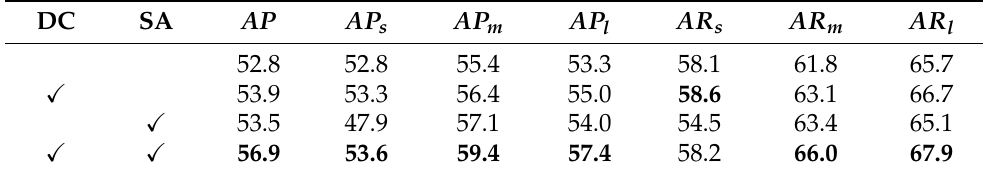
Table 3. Ablation study results for the two proposed strategies. We use “ DC “ to denote the densely connected module in the backbone networks and “ SA “ to denote the scale adaptation